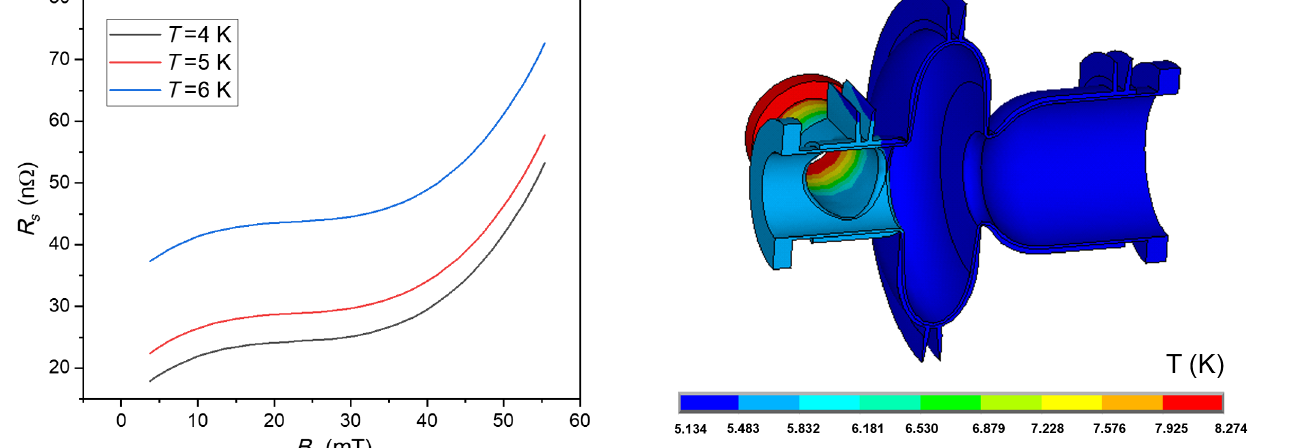
FIG. 4. Empirical field dependence of the surface resistance used in the thermal analysis calculated at three different temper- atures.